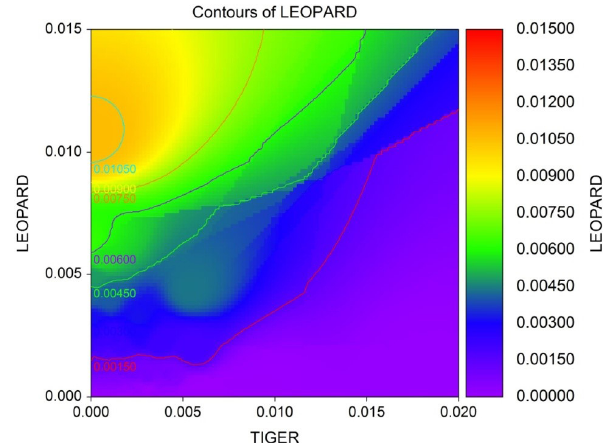
Figure 3. Diagrammatic representation of leopard density contours against tiger density areas. Plotted density contours of leopards against that of tigers show that density of leopards declines with increase in the density of